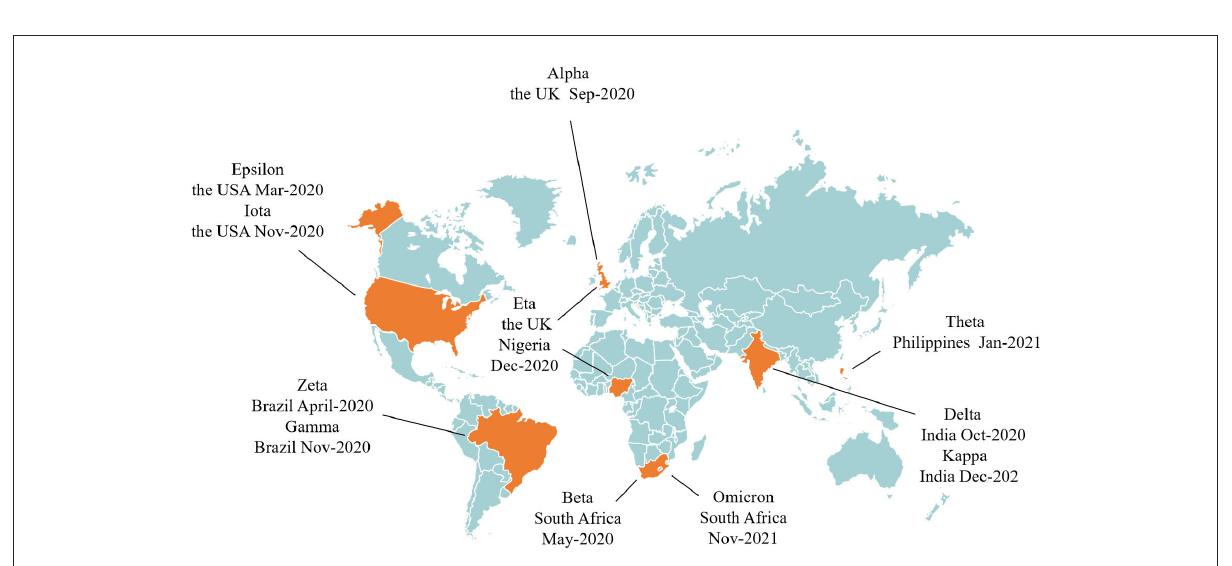
FIGURE1 The time and place of discovery of SARS-CoV-2